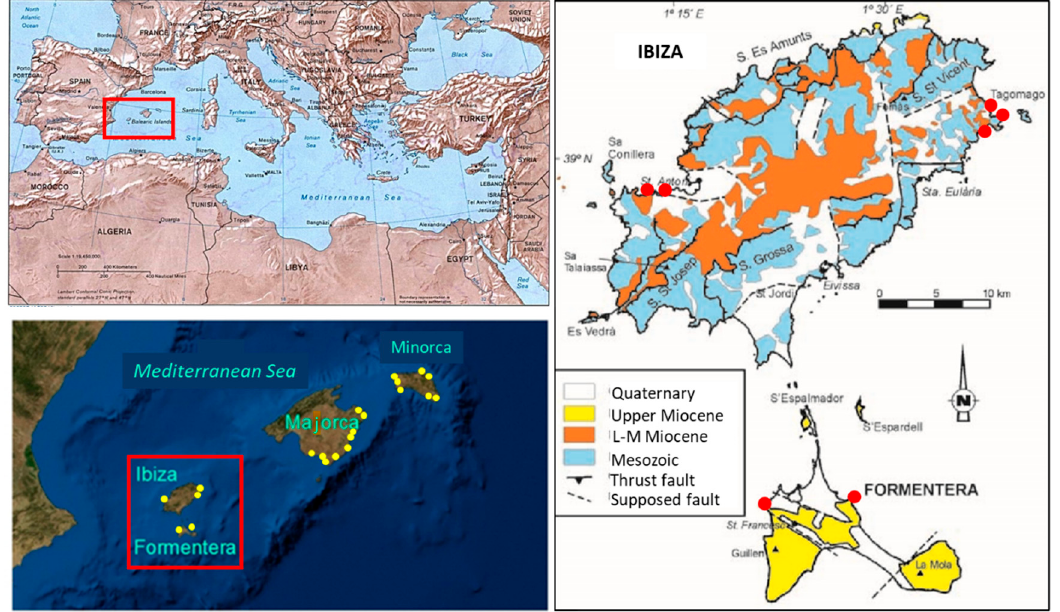
Figure 1. Setting and geological framework of Ibiza and Formentera Islands. Red and yellow dots correspond to the boulder outcrops analyzed.